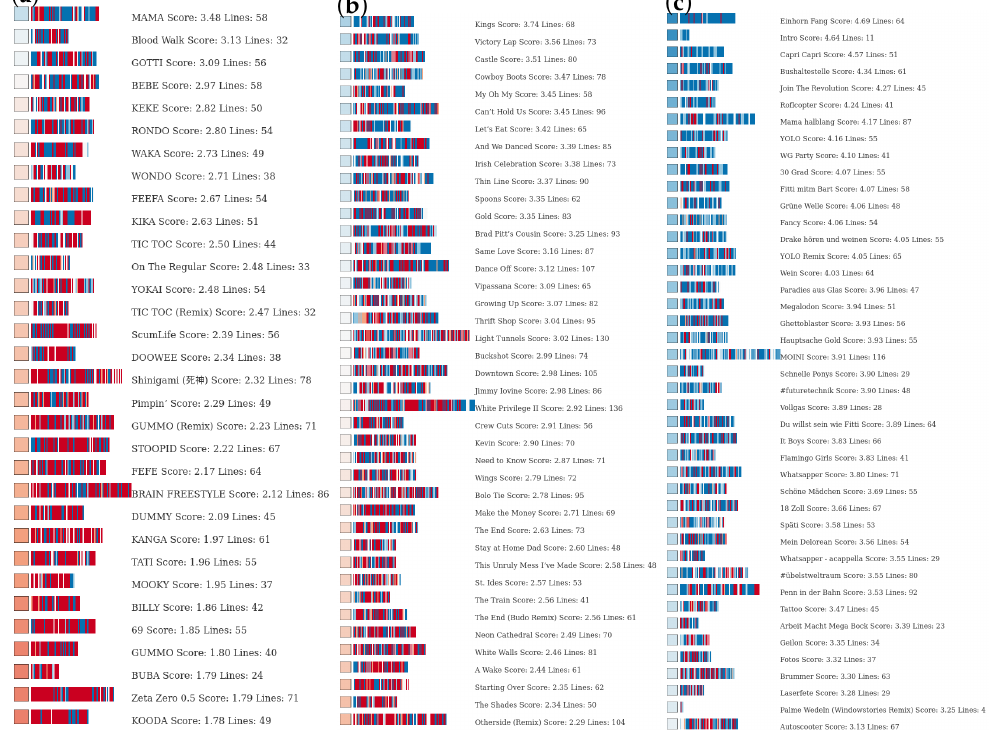
Figure 11. Sentiment Barcodes for the songs of 6ix9ine ( a ), Macklemore and Ryan Lewis ( b ), and MCFitti ( c ). A red bar indicates a negative sentiment, and a blue indicates a positive sentiment for a